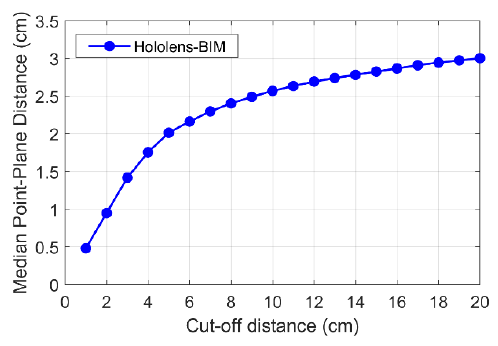
Figure 11. Median point-model distance between the Hololens mesh and the 3D model.